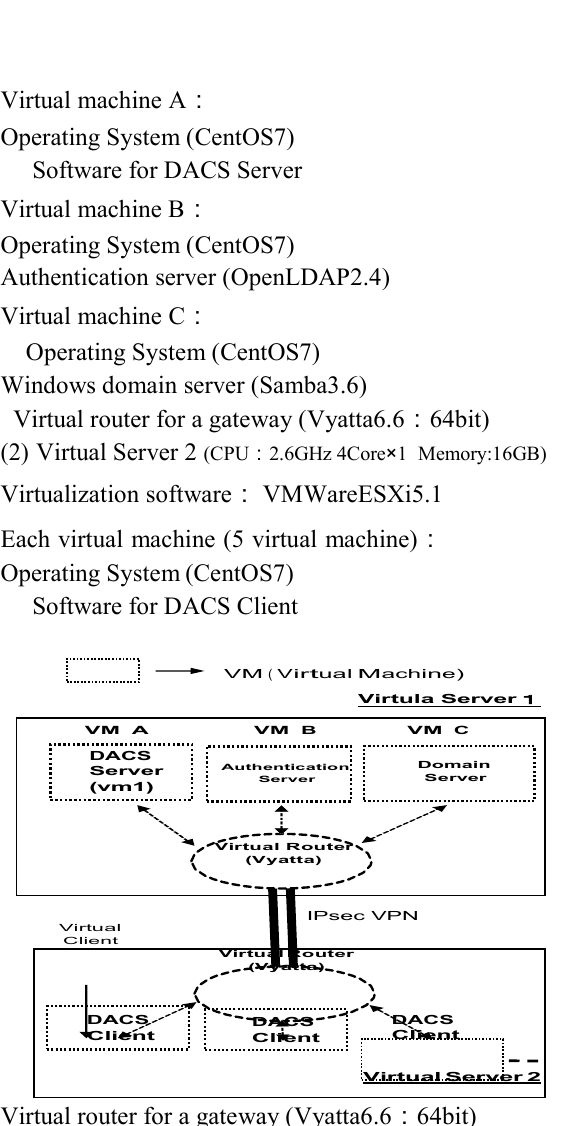
Figure.10 Prototype system